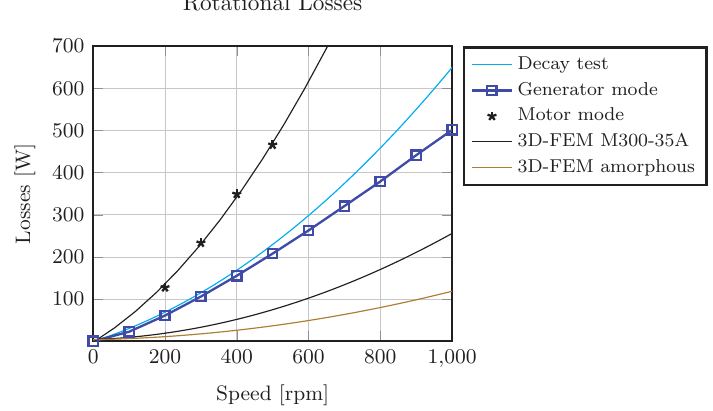
Figure 33. Calculated and measured no-load losses of the HM3D